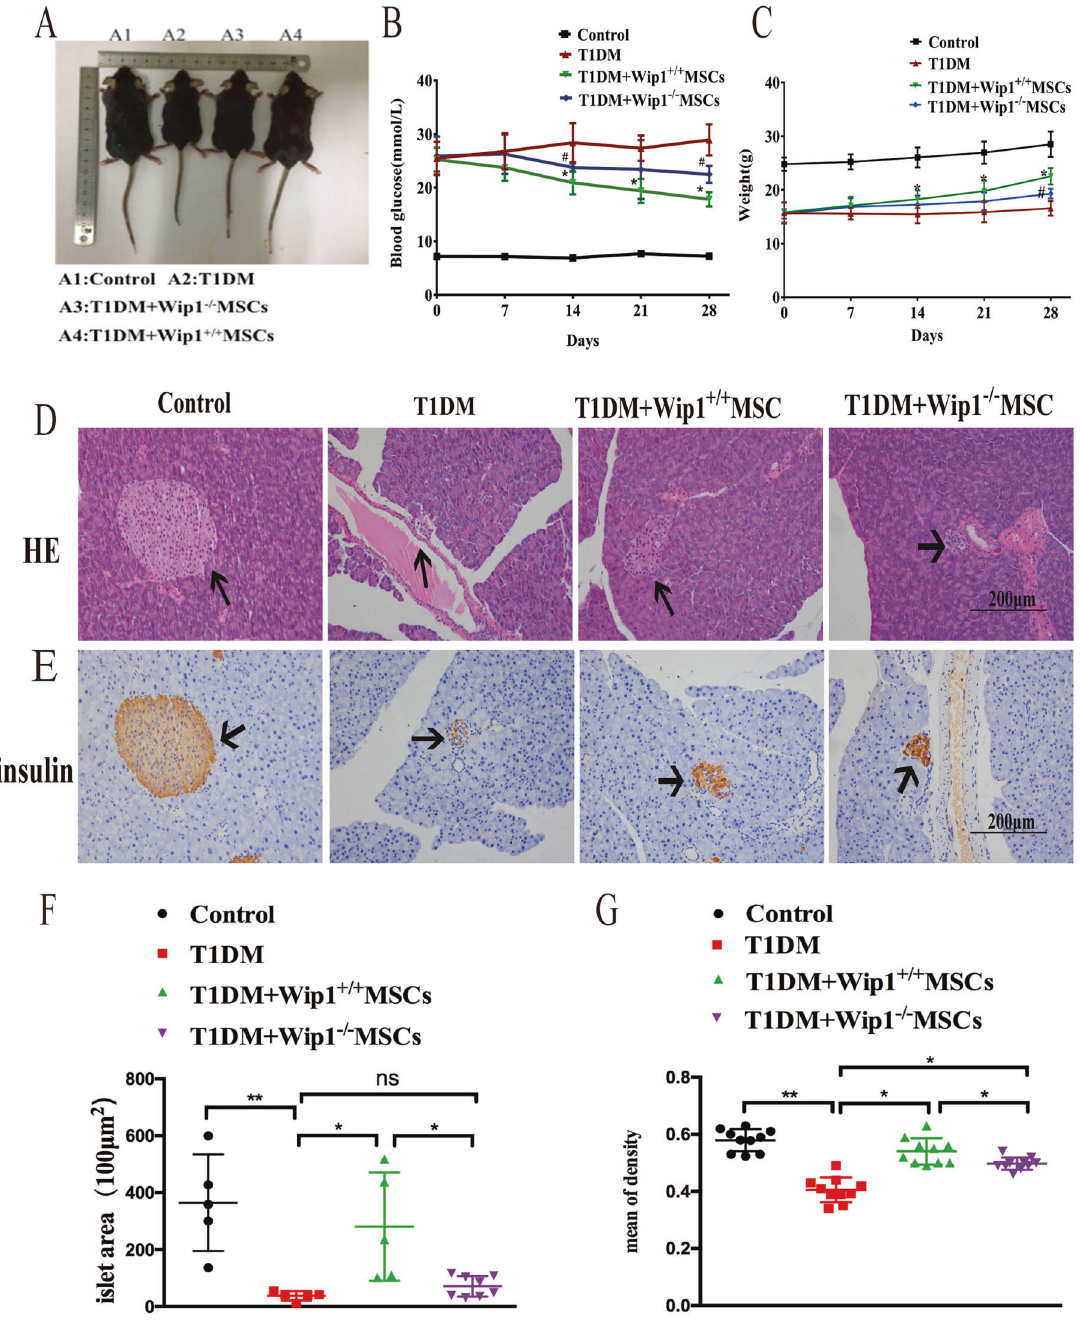
Fig. 2 Wip1 knockout impaired the therapeutic ef fi cacy of MSCs in T1DM mice. A The body size of mice after infusion of Wip1 + / + MSCs and Wip1 − / − MSCs. B , C The blood glucose and the weight curves. D , E Pathological damages in pancreatic tissue by H&E staining and immunohistochemical staining. F , G The islet area and the mean density of insulin-positive cells in pancreatic tissues treated with Wip1 − / − MSCs were smaller than that of the Wip1 + / + MSCs group. ( n = 8, three independent experiments), # P < 0.05, * P < 0.05, ** P < 0.01. (519.02 ± 47.01 pg/ml) in the T1DM group were signi fi cantly splenic lymphocytes. The expression of IFN- α , IFN- β , and IFN- γ in higher than those in other groups ( P < 0.05). After treating with the Wip1 − / − MSCs group was higher than that of the Wip1 + / + MSCs group, which indicated that Wip1 − / − MSCs also could Wip1 + / + MSCs, the expression of TNF- α (827.03 ± 102.08 pg/ml) promote the expression of IFN- α , IFN- β , and IFN- γ in spleen and IL-17a (283.53 ± 48.26 pg/ml) showed signi fi cant decline lymphocytes, and further aggravate the in fl ammatory response compared with those in T1DM group ( P < 0.05), while the (Fig. S1). expression of TNF- α (995.24 ± 562.61 pg/ml) and IL-17a (413.33 ± The expression of in fl ammatory cytokines (e.g., TNF- α , IL-17a, IL- 42.98 pg/ml) in Wip1 − / − MSCs treatment group was signi fi cantly 4, and IL-10) in the pancreas supernatant was measured by ELISA. higher than those in Wip1 + / + MSCs group ( P < 0.05). The expres- The expression of TNF- α (1027.87 ± 82.9 pg/ml) and IL-17a sion of IL-4 (50.25 ± 28.14 pg/ml) and IL-10 (1575 ± 579.38 pg/ml) Cell Death Discovery (2021)